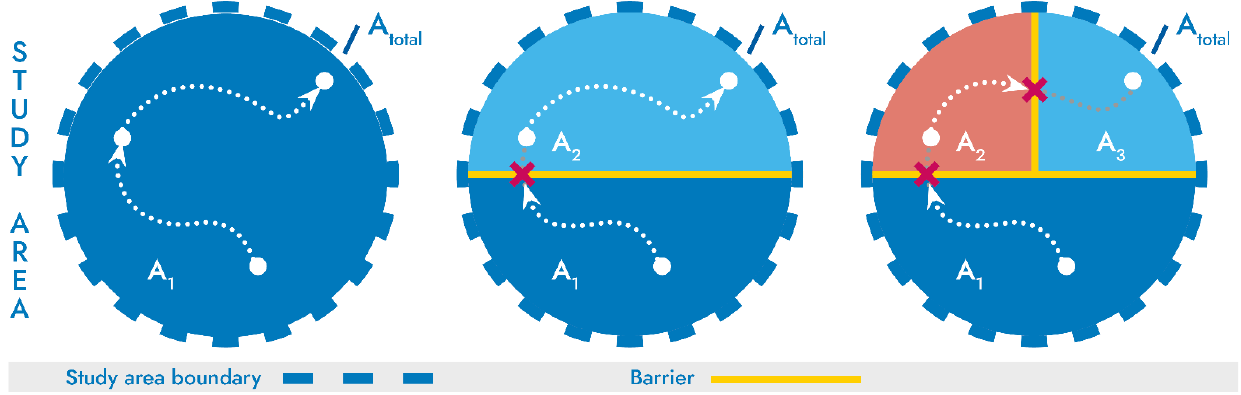
Figure 6. The main concept of the effective mesh size.